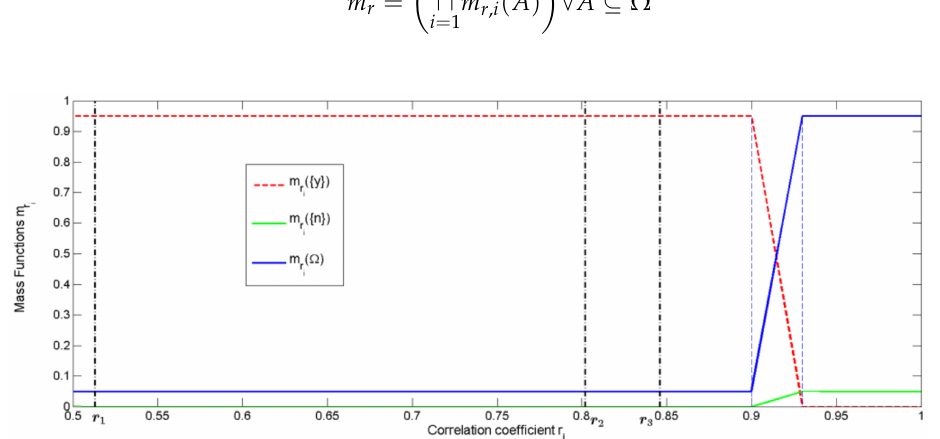
Figure 6. Evolution of the mass function as a function of the value of the correlation coefficient r i